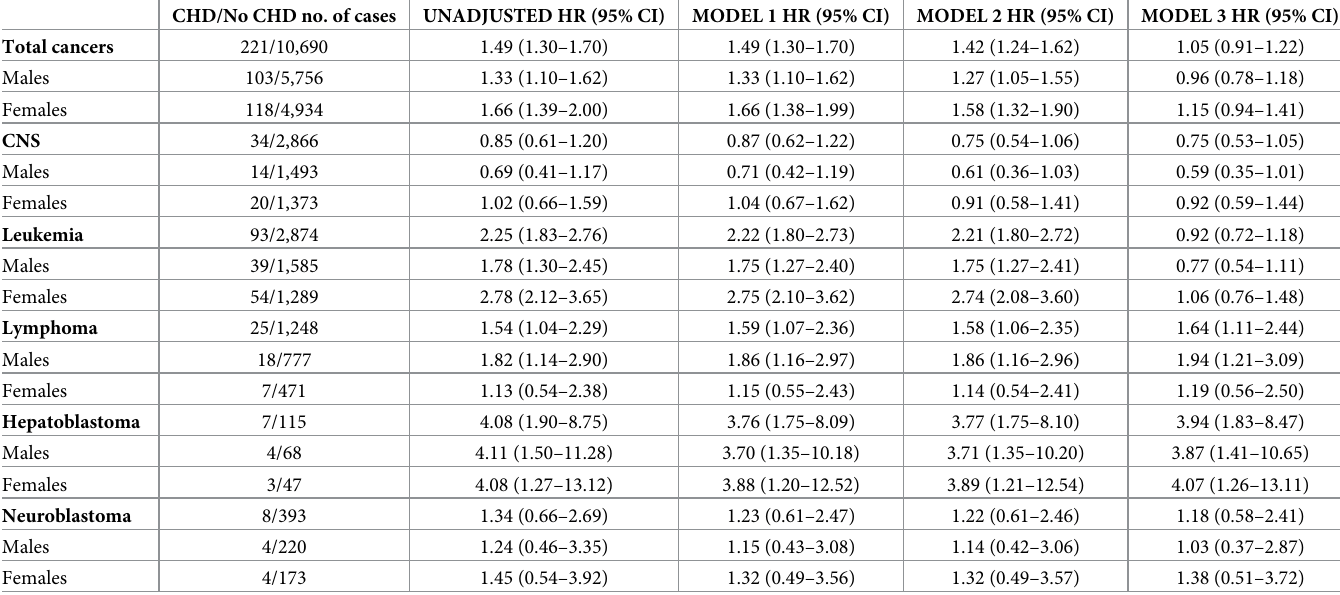
Table 2. Adjusted HRs (95% CIs) of cancer in children with CHD.